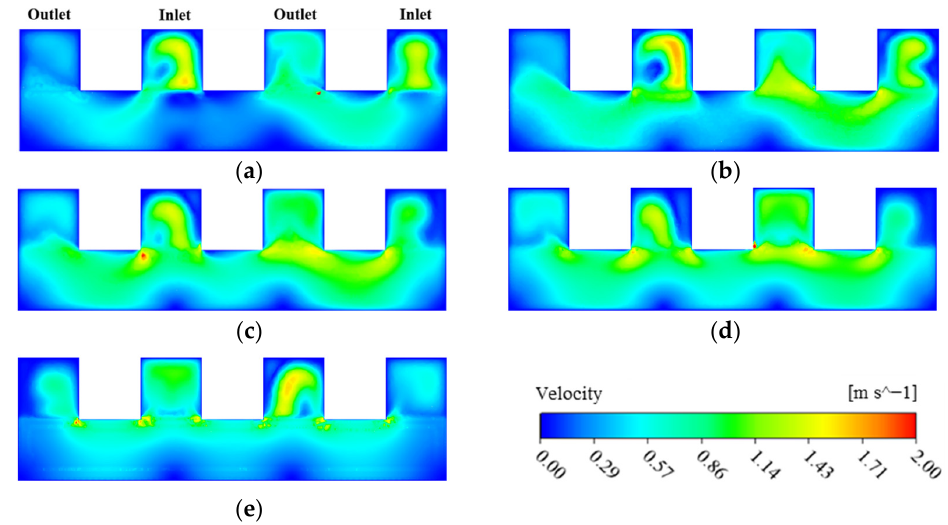
Figure 12. The velocity distribution of the channel under the flow field-1. ( a ) N = 10; ( b ) N = 12; ( c ) N = 16; ( d ) N = 24; ( e ) N = 48.